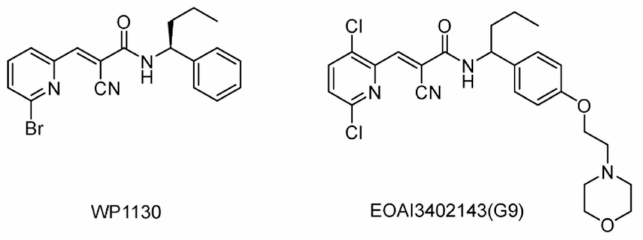
Figure 13. Structures of reported USP5/9X/14/24/UCHL5